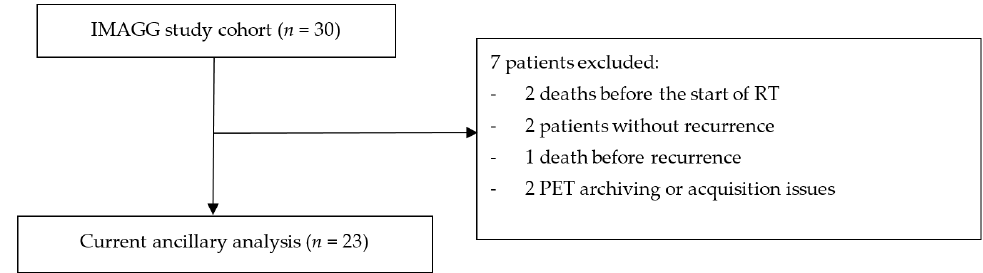
Figure 8. Flowchart.